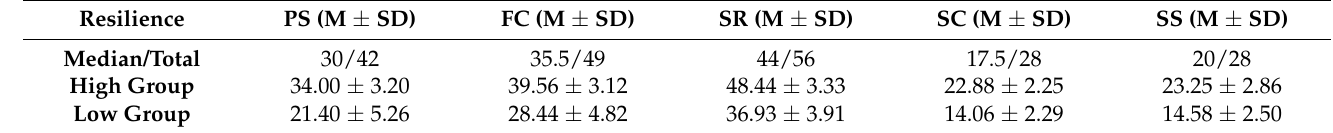
Table 2. Summary statistics of the RSA scores (N =